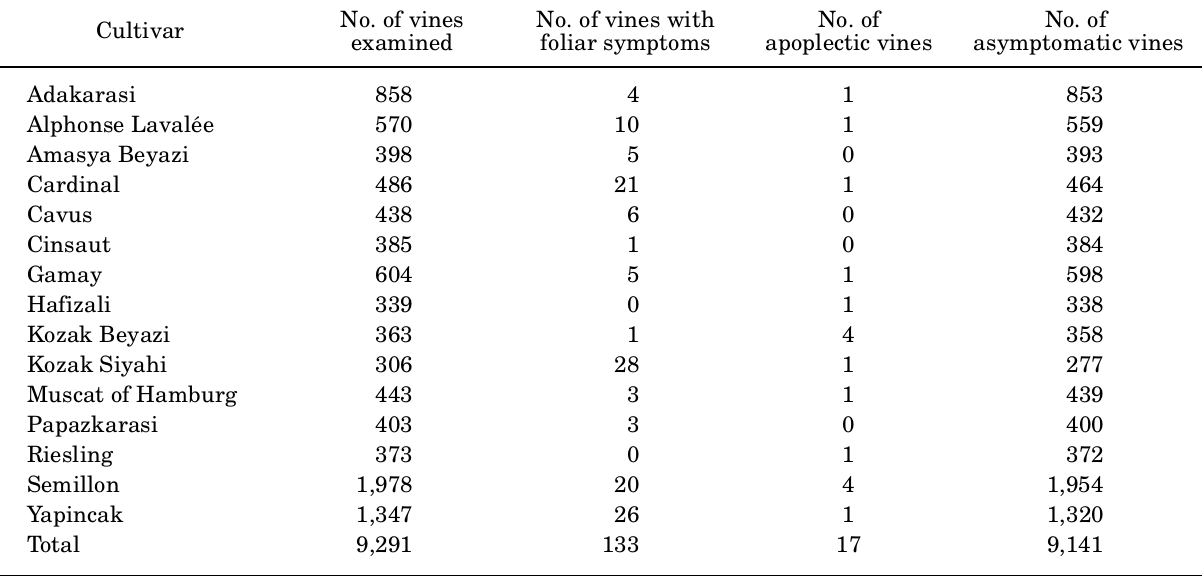
Table 1. Incidence of esca in grapevine cultivars grown in Thrace region, Turkey, in 1999.